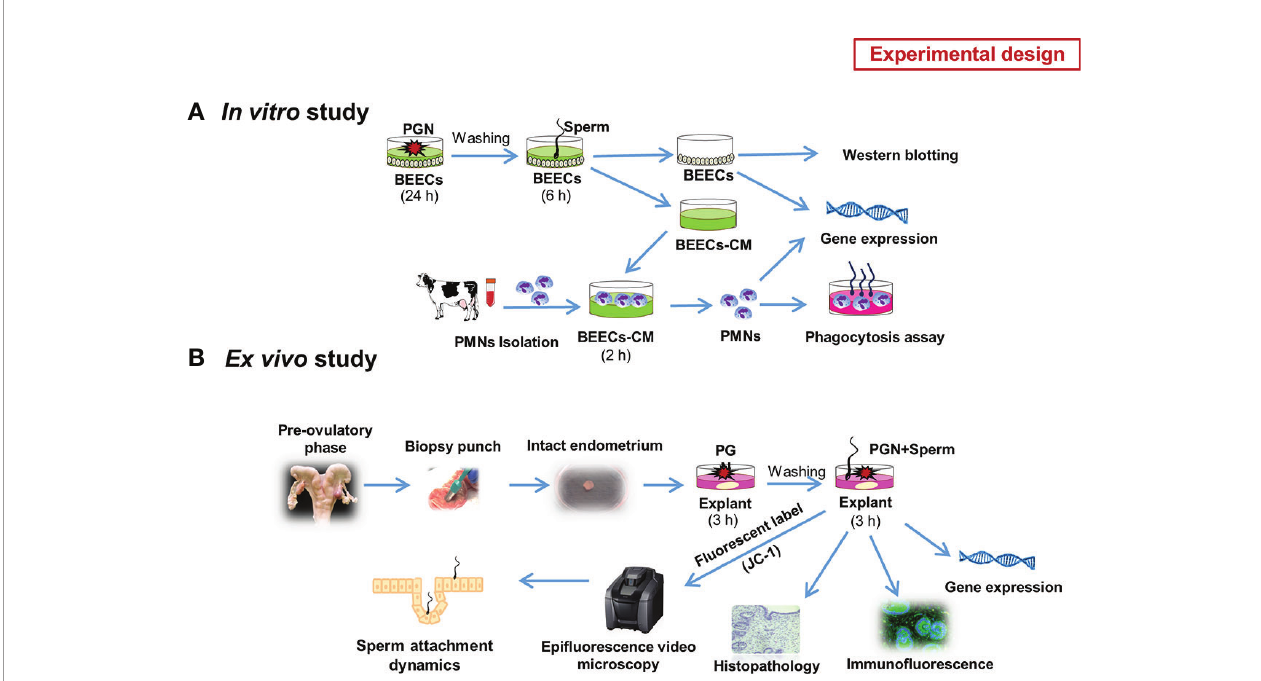
FIGURE 1 | Schematic representation of the study experimental design: (A) in vitro model. Initially we investigated the competitive interaction of LPS/PGN and sperm with endometrial epithelium using RT-PCR. Based on the results, we gave more focus on the impact of low concentrations of PGN on sperm-induced in fl ammation in endometrial epithelium. As a main experiment, Subcon fl uent BEEC monolayers (90%) were stimulated with PGN (10 pg ml − 1 ) for 24 h, followed by co-culture with sperm (5 × 10 6 ml − 1 ) for 6 h. The impact of PGN on sperm-induced immune responses in BEECs was assessed using RT-PCR. Later on, sperm- triggered MAPK cascade components in BEECs were assessed using western blotting. Conditioned medium (CM) from a sperm-BEEC co-culture after pre-exposure to PGN was harvested and exploited to challenge peripheral PMNs, isolated from mature healthy cows, for 2 h. Subsequently, PMN immune responses and phagocytic activity toward sperm were measured (A) . To assess direct BEEC response to PGN alone, BEECs were exposed to different concentrations of PGN at different time points. For activation or blockage of the TLR2 pathway, a TLR2 agonist (pam3Cys) or antagonist (CU-CPT22) was used, respectively. (B) ex vivo model. An explant model of intact endometrium was used to explore the sites of interactions and sperm dynamics with endometrial epithelium. We investigated immune responses and histomorphology induced by sperm in endometrial tissue in the presence of PGN. Additionally, we used high-resolution 3D imaging microscopy to trace sperm dynamics and attachment after JC-1 mitochondrial illumination of their mid-pieces (B)